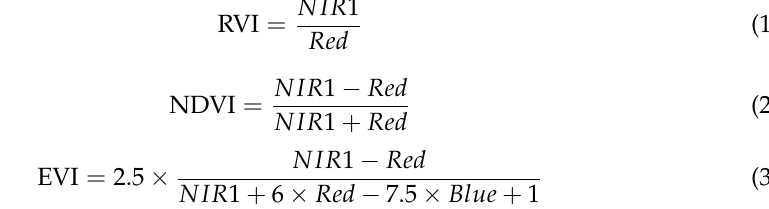
Table 2. Variables used for crop classification derived from the different types of image features.